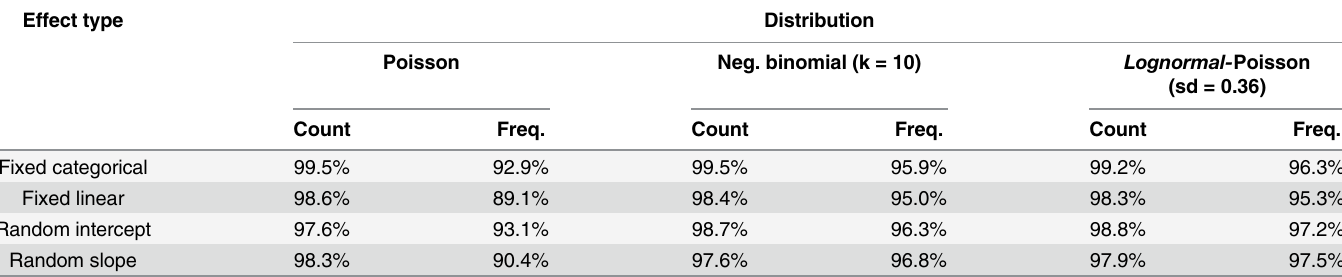
Table 2. Area under curve (AUC) for the different combinations of effects and distributions. In the analysis, the best model (Poisson, negative binomial and zero-inflated negative binomial for count data) with and without effect was identified and compared to each other using BML. Delta AUC is also given to illustrate the difference between the two models utilizing the two different data types (counts and frequencies). Note that the analyses using count data always perform better than the analyses using frequency data, though the difference is, in some cases marginal, e.g. random slope models drawn from datasets built on negative binomial or lognormal Poisson